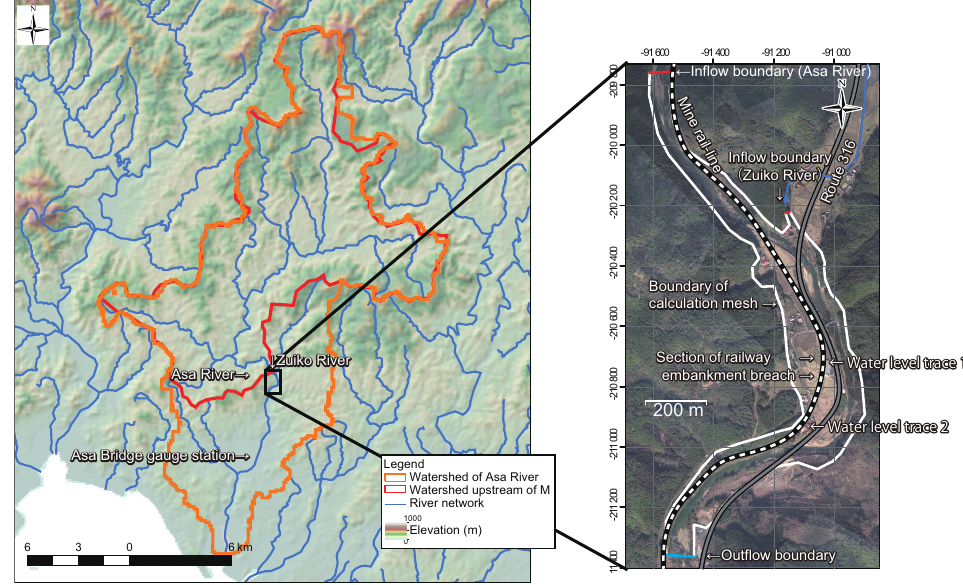
Figure 4. Watershed of the Asa River (left) and aerial photo taken in 2011 of section M (right). (Source: National Land Numerical Information download service, Ministry of Land, Infrastructure, Transport and Tourism, Japan, for digital elevation model, watersheds, and river